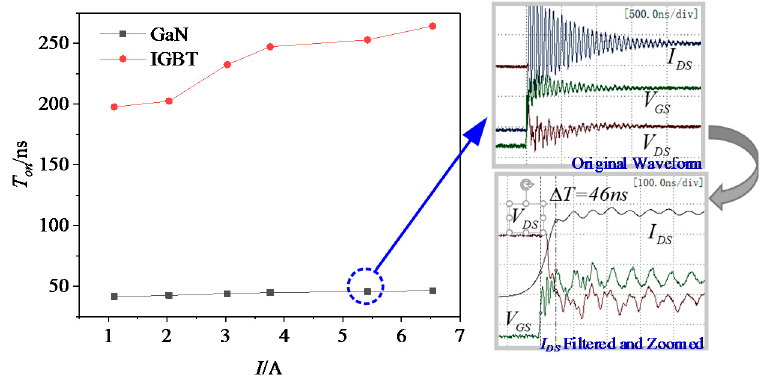
Figure 6. Experimentally measured GaN HEMT and IGBT turn-on time.